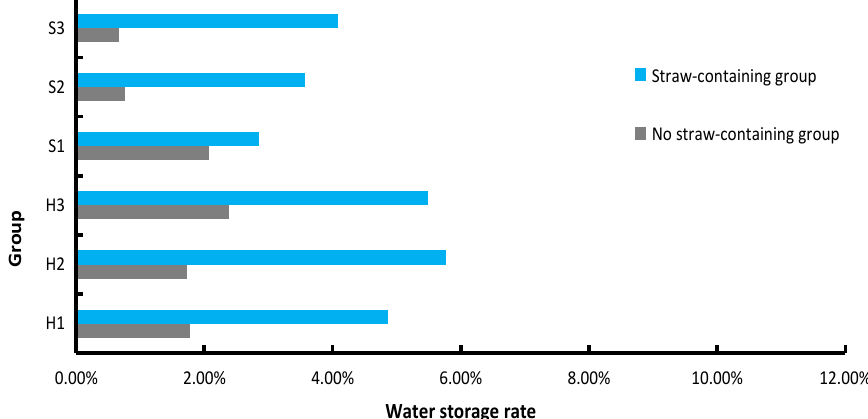
Figure 6. Comparison of water storage rate of specimens after 48 h immersion.